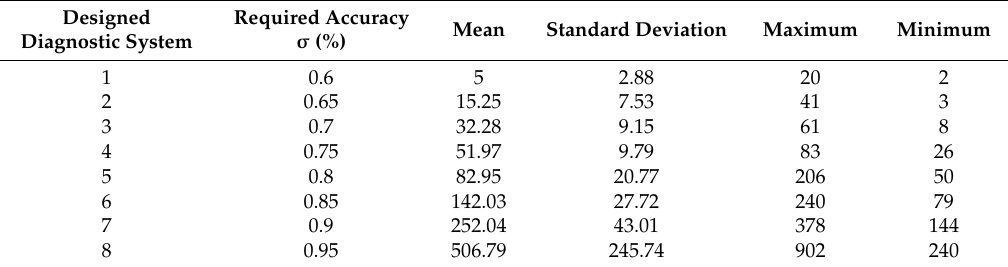
Table 3. The statistics for the designed diagnostic system in group A.